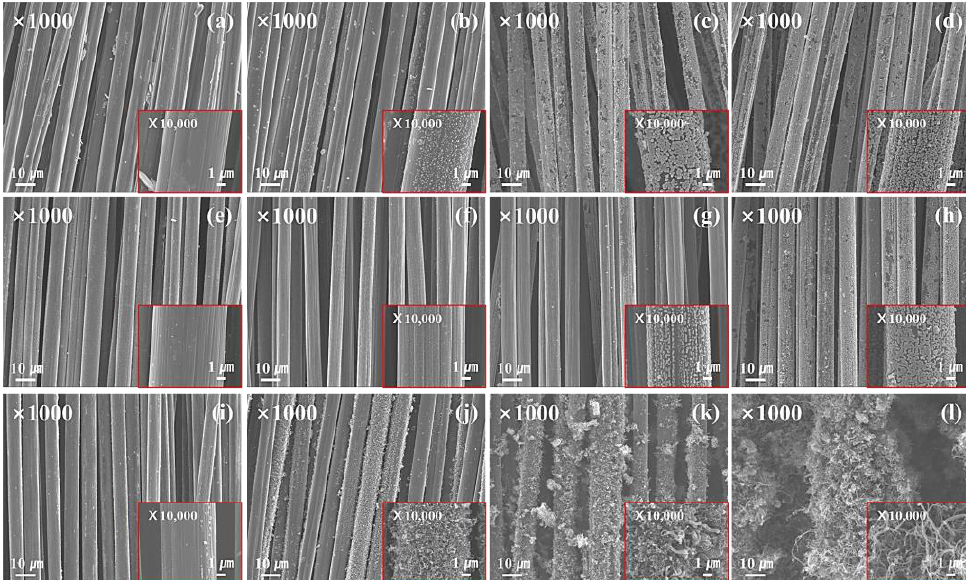
Figure 1. SEM images of the carbon fiber with CNTs grown on the surface; Ni-P-plated glass fiber; ( a ) NCF-10, ( b ) NCF-30, ( c ) NCF-60, ( d ) NCF-120, post-heat-treated glass fiber after Ni-P plating; ( e )